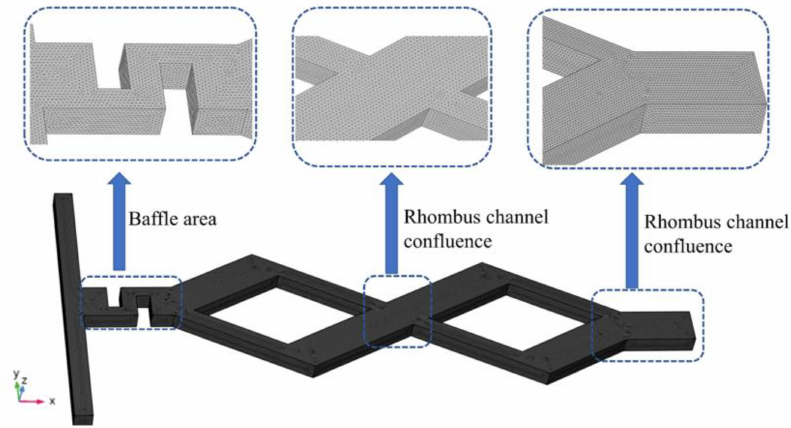
Figure 2. Computational mesh. Table 2. The calculated data of grid convergence index.